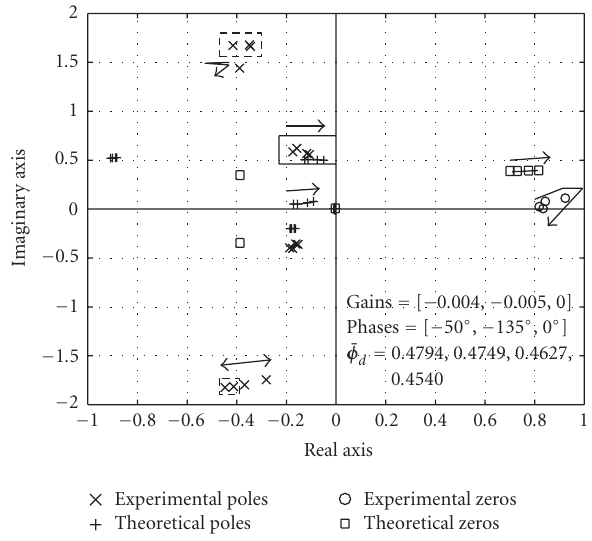
Figure 10: Closed-loop root locus for harmonic 1 with varying flow coe ffi